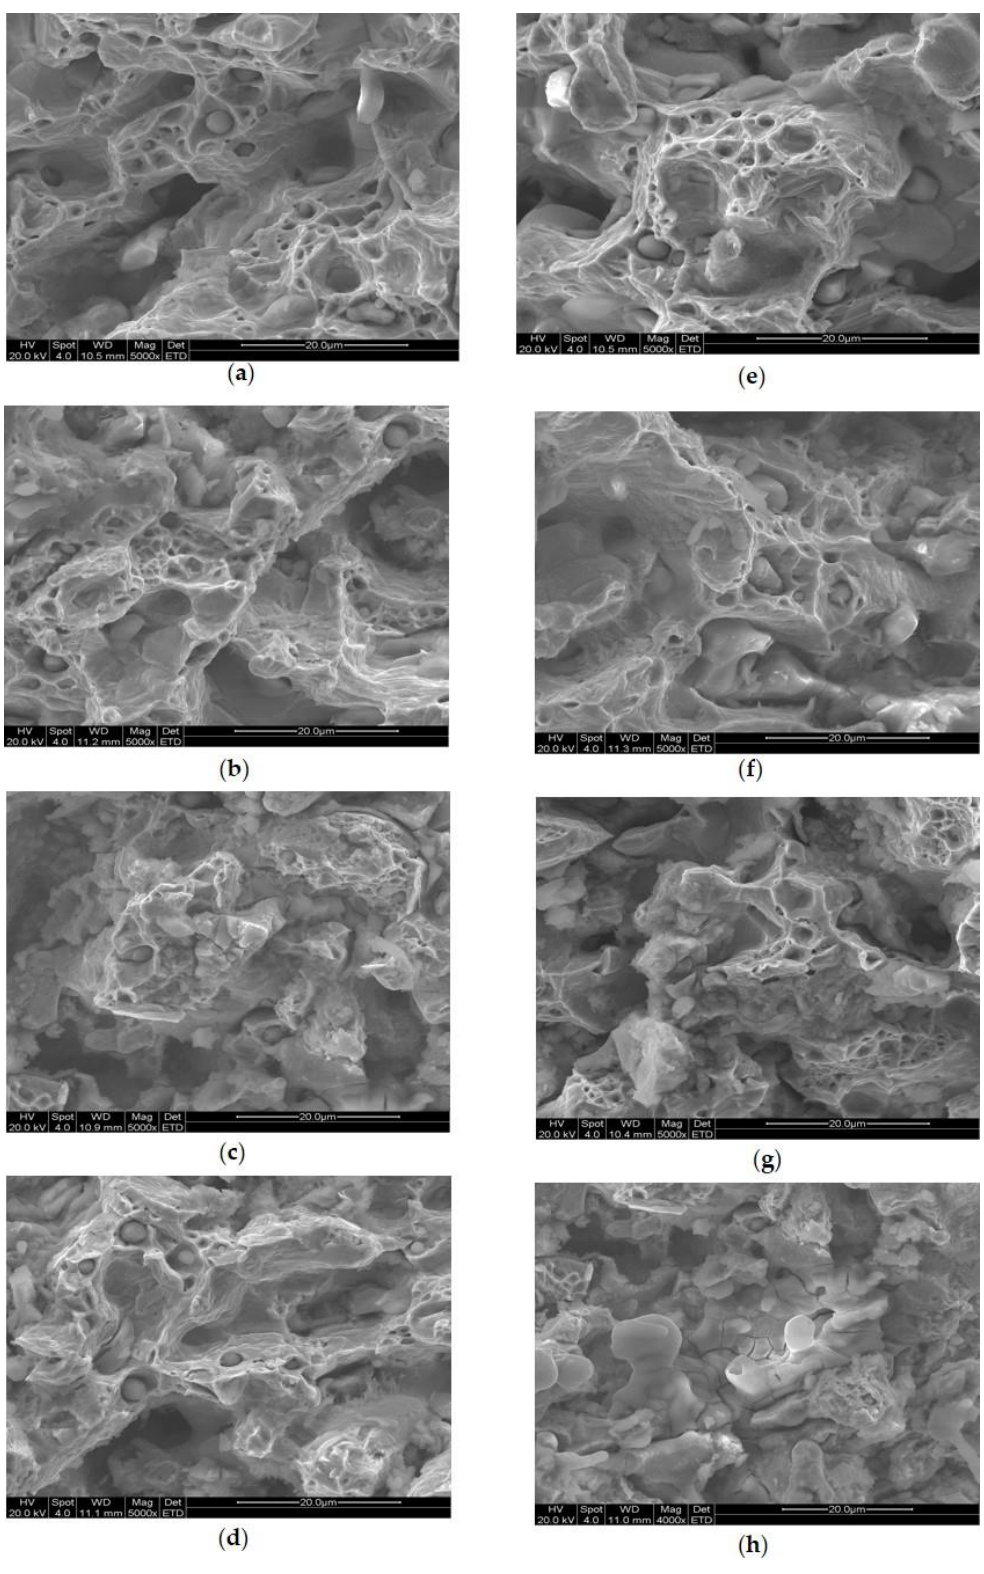
Figure 6. Fracture surface of the as-sintered Fe–28Mn-based alloys immersed in SBF solution for different durations: ( a ) Fe–28Mn–3Si alloy with no immersion; ( b ) Fe–28Mn–3Si alloys immersed for 15 days; ( c ) Fe–28Mn–3Si alloys immersed for 45 days; ( d ) Fe–28Mn–3Si alloys immersed for 60 days; ( e ) Fe–28Mn alloys without immersion; ( f ) Fe–28Mn alloys immersed for 15 days; ( g ) Fe–28Mn alloys immersed for 45 days; ( h ) Fe–28Mn alloys immersed for 60 days.